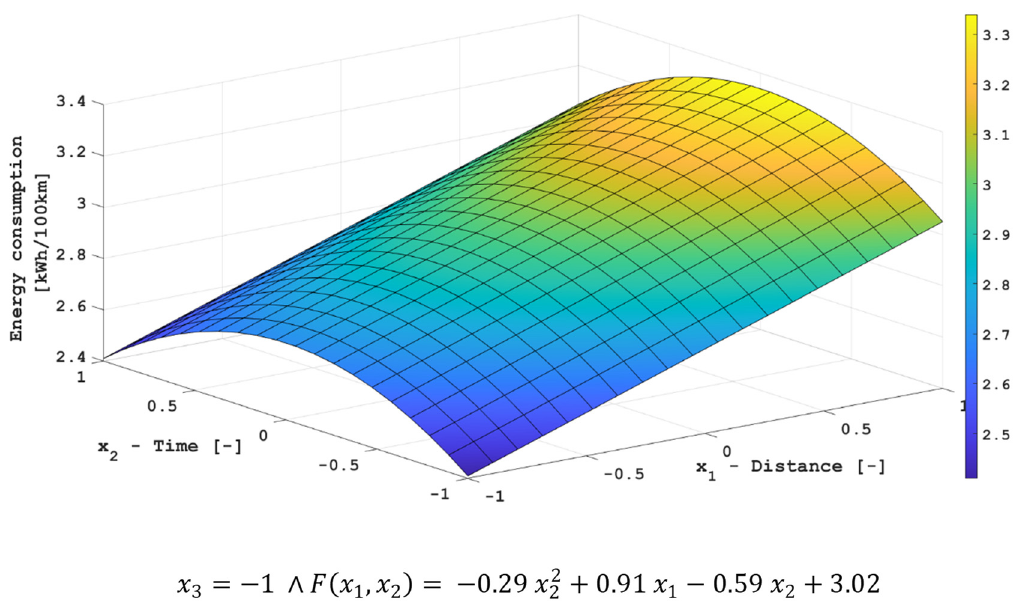
Figure 10. The consumption values of an electric scooter at a temperature of 15 °C.